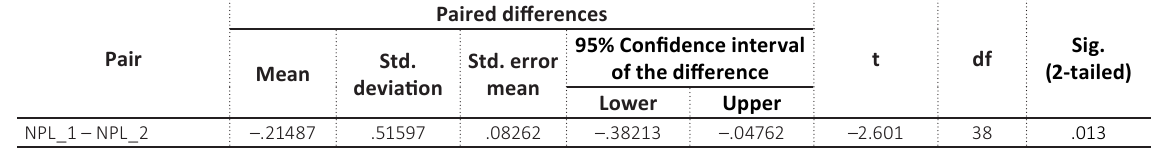
Table A3. Paired samples correlations (the result of H1b )